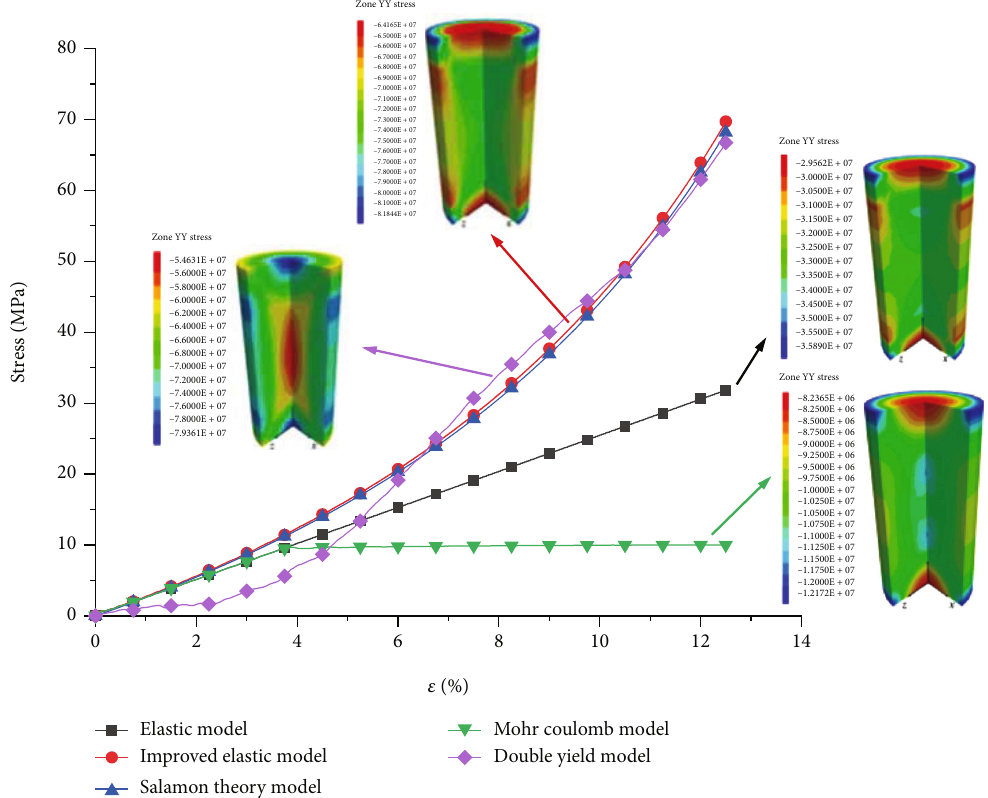
Figure 4: Compaction characteristics of models under di ff erent constitutive